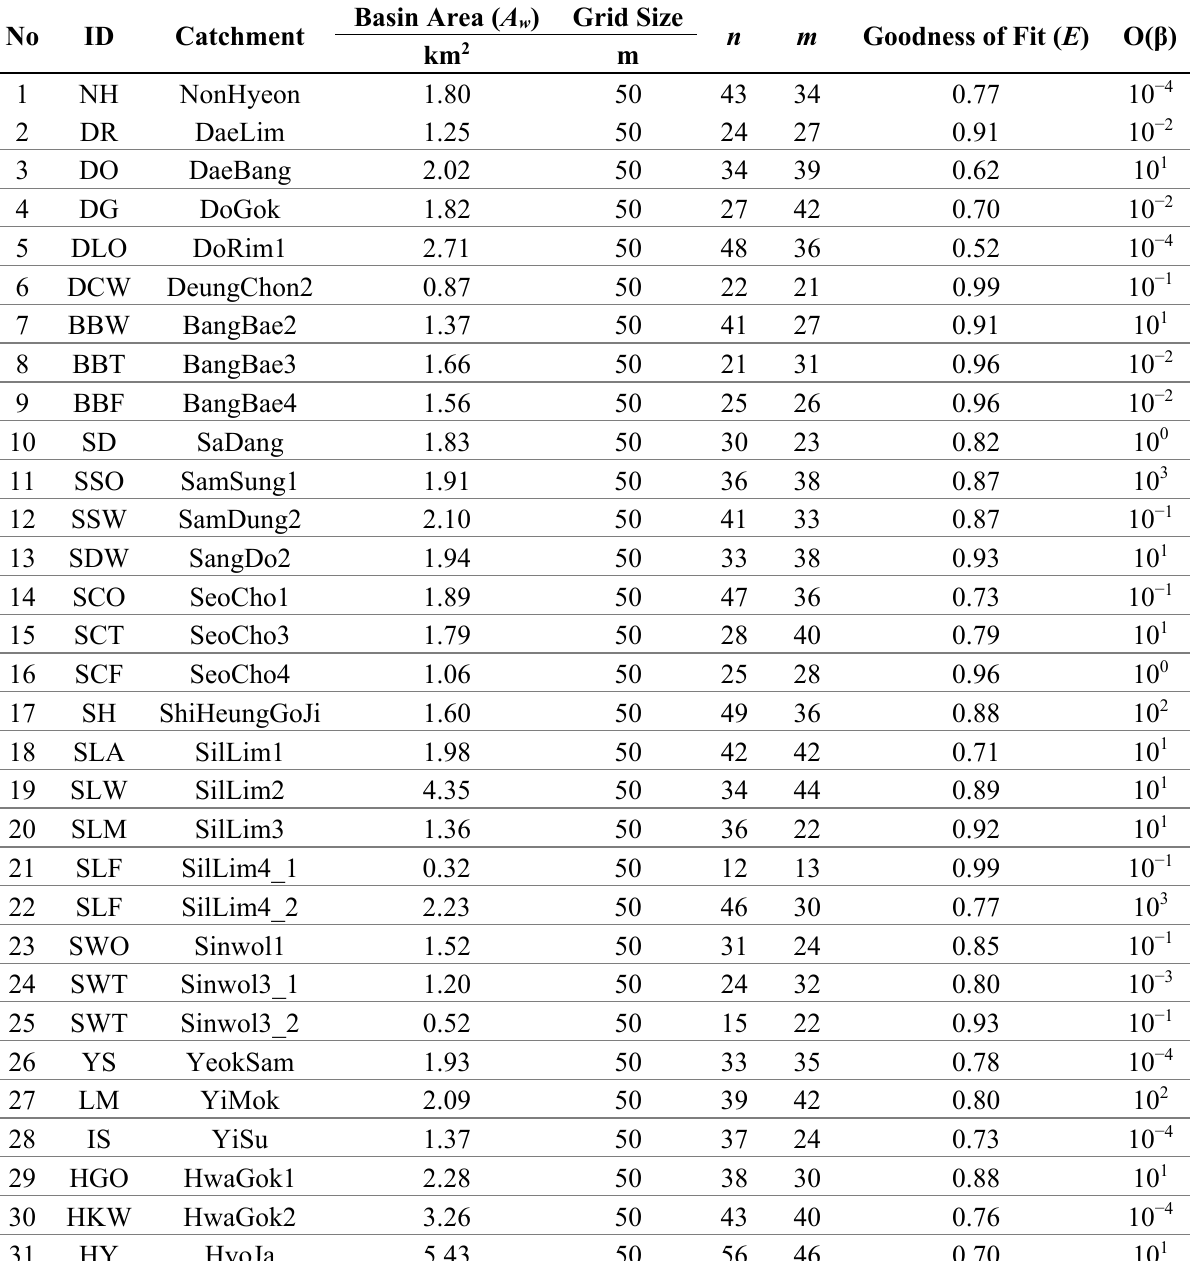
Table 2. Network configuration of drainage networks in